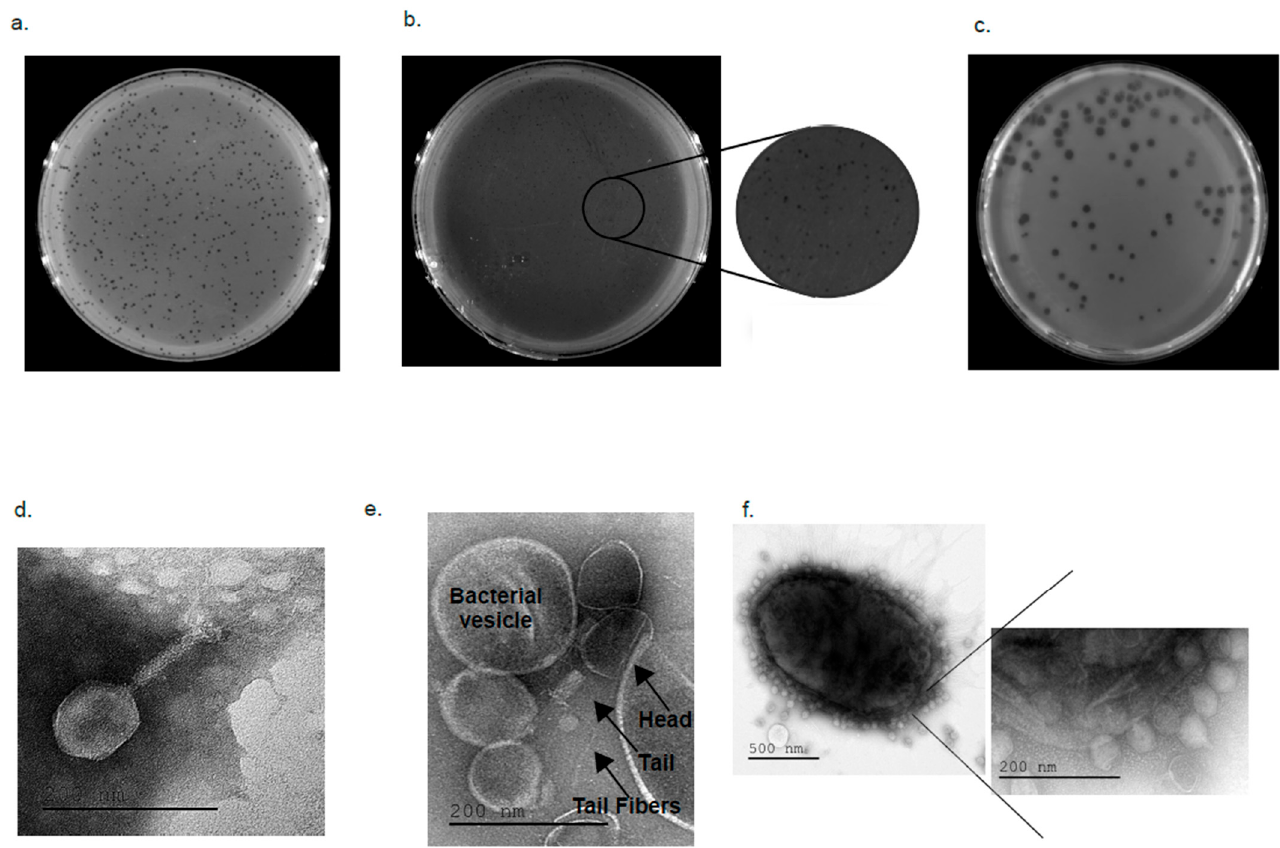
Figure 3. Plaque morphologies and TEM microscopy of anti- Providencia phages. Single plaques of PSTCR4 ( a ), PSTCR6 ( b ) on P.st 8, and PSTCR2 ( c ) on P. rett10 on bacterial lawns. Geometric structure of PSTCR4 ( d ); PSTCR6 ( e ); and PSTCR2 attached to its host P. rett10 ( f ) .